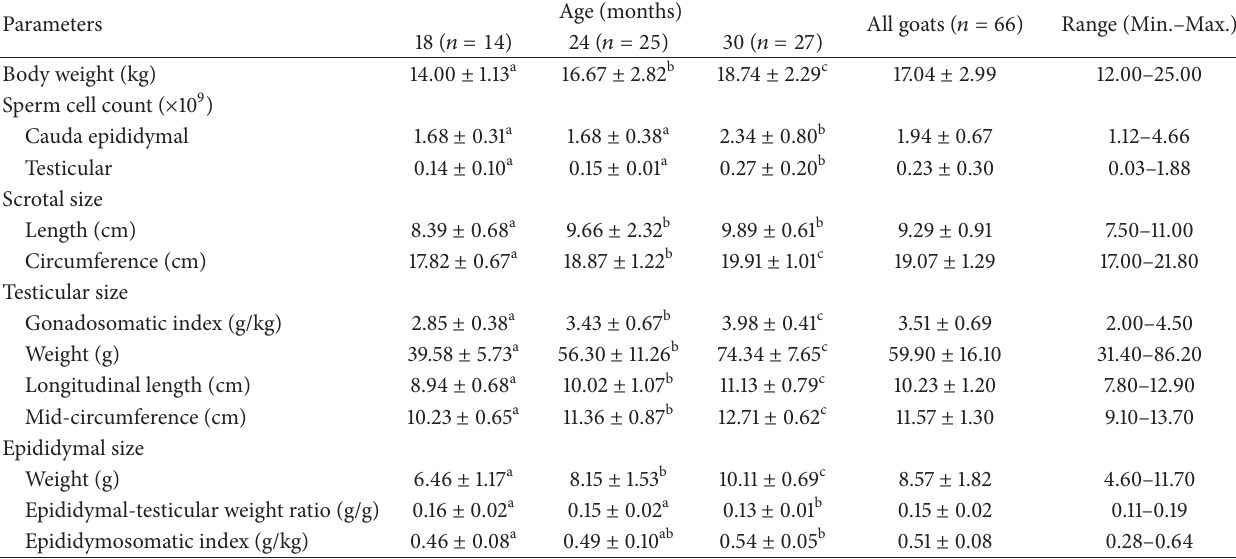
Table 1: Age-related variations in body weights, testicular and epididymal size estimates, and sperm counts in Nigerian Sahel goats. Parameters